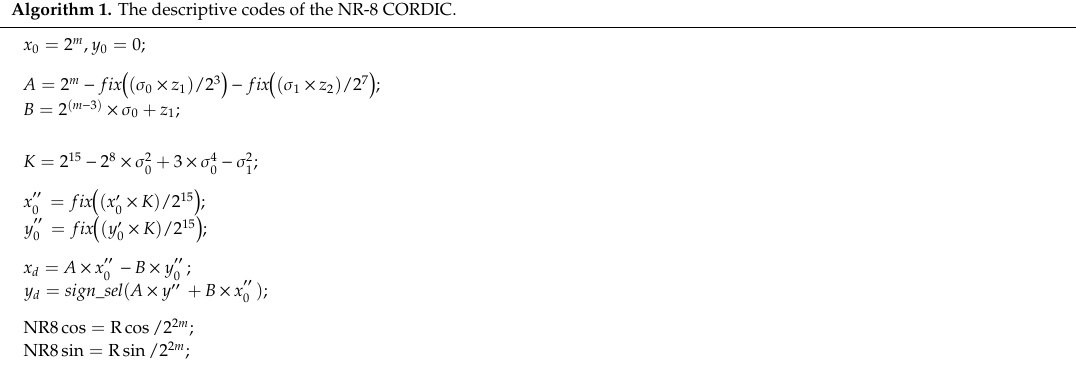
Algorithm 1. The descriptive codes of the NR-8